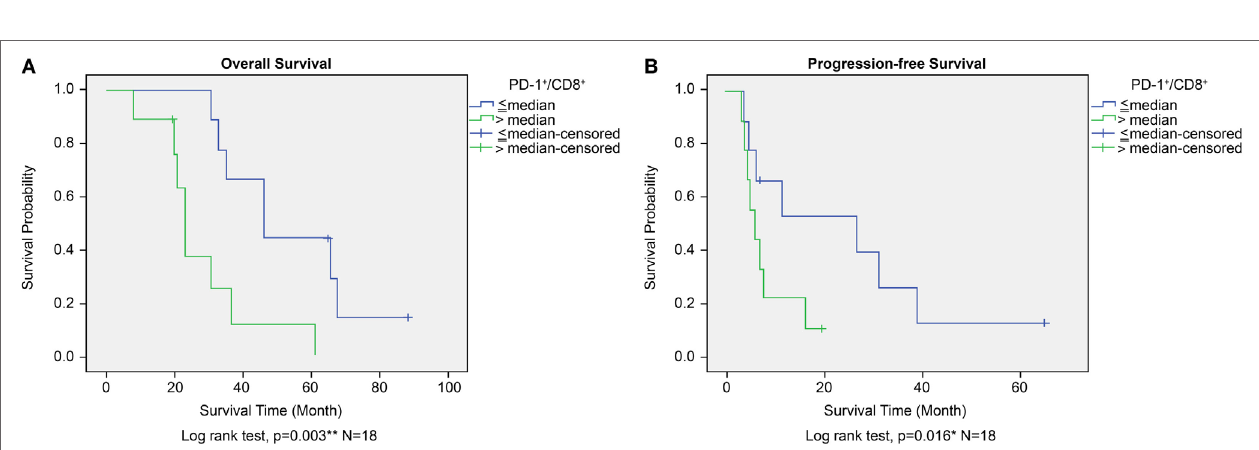
FigUre 8 | Overall survival (OS) (a) and progression-free survival (PFS) (B) according to high or low PD-1 + /CD8 + ratio in peripheral blood mononuclear cells in the ADCTA group. Kaplan–Meier survival plots of OS and PFS of 10 high PD-1 + /CD8 + ratio patients compared to 8 low PD-1 + /CD8 + ratio